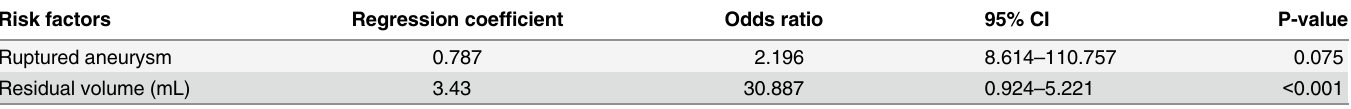
Table 3. Multivariate logistic regression analysis with four variables (residual volume, neck, stent, and ruptured aneurysm). Risk